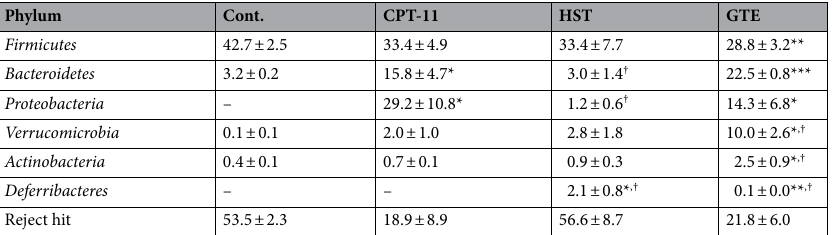
Table 1. Phylum level proportions of gut microbiota. Rats were administered CPT-11 or lactic acid buffer intravenously for 4 days, and HST or GTE was administered in combination. The relative abundance at the phylum level in the gut microbiota was measured by next-generation sequencing. “–” indicates that the value is greater than 0 and less than 0.1 (mean ± S.D., n = 3, * p < 0.05, ** p < 0.01, *** p < 0.001 vs. Cont., † p < 0.05 vs.